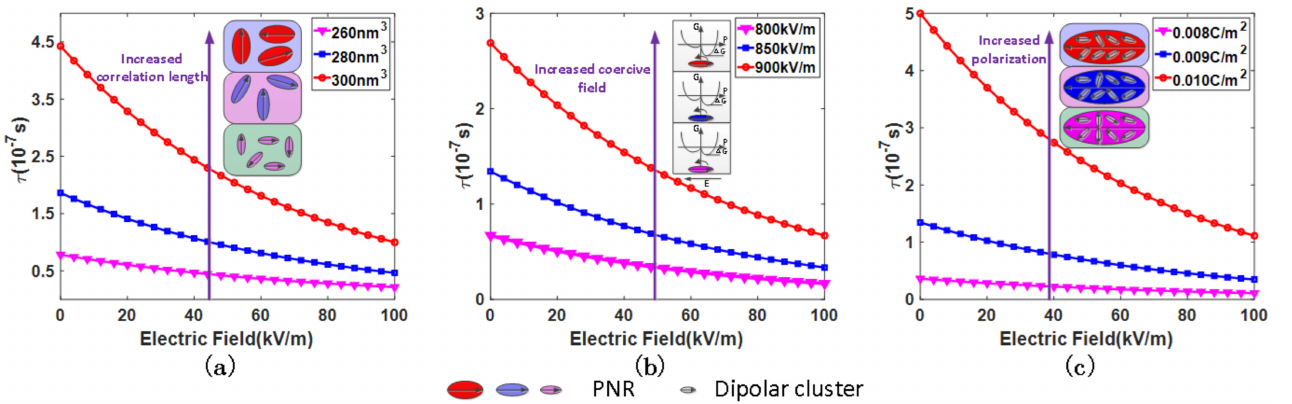
Figure 1. Electric field dependence of relaxation time ( a ) under a different volume of PNRs and ( b ) under a different coercive field. The inset shows the Gibbs free energy versus the polarization, and PNR orients to the direction with lower energy. ( c ) The PNRs overcome the coercive field and reorientate along the direction of electric field under different polarization. The orientation consistency of dipole clusters indicates the polarization. The purple arrow shows the diversity of relaxation time when the same parameter is taken with different values under the same bias electric